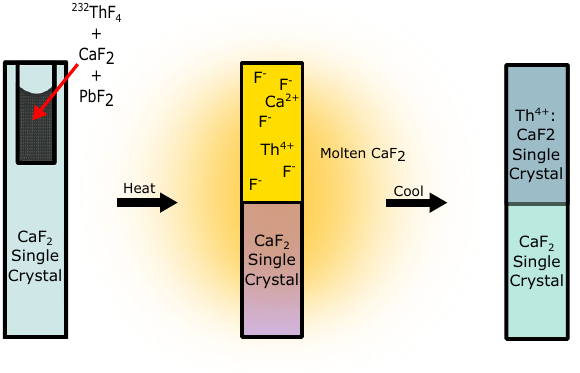
Figure 1. Simplified schematic representation of the vertical gradient freeze method applied to the seed crystal filled with dopant powder. While applying a steep temperature gradient, the top of the crystal melts and becomes a liquid while the bottom remains solid. By slowly cooling and moving the melting interface upwards, a doped single crystal can be grown on the seed